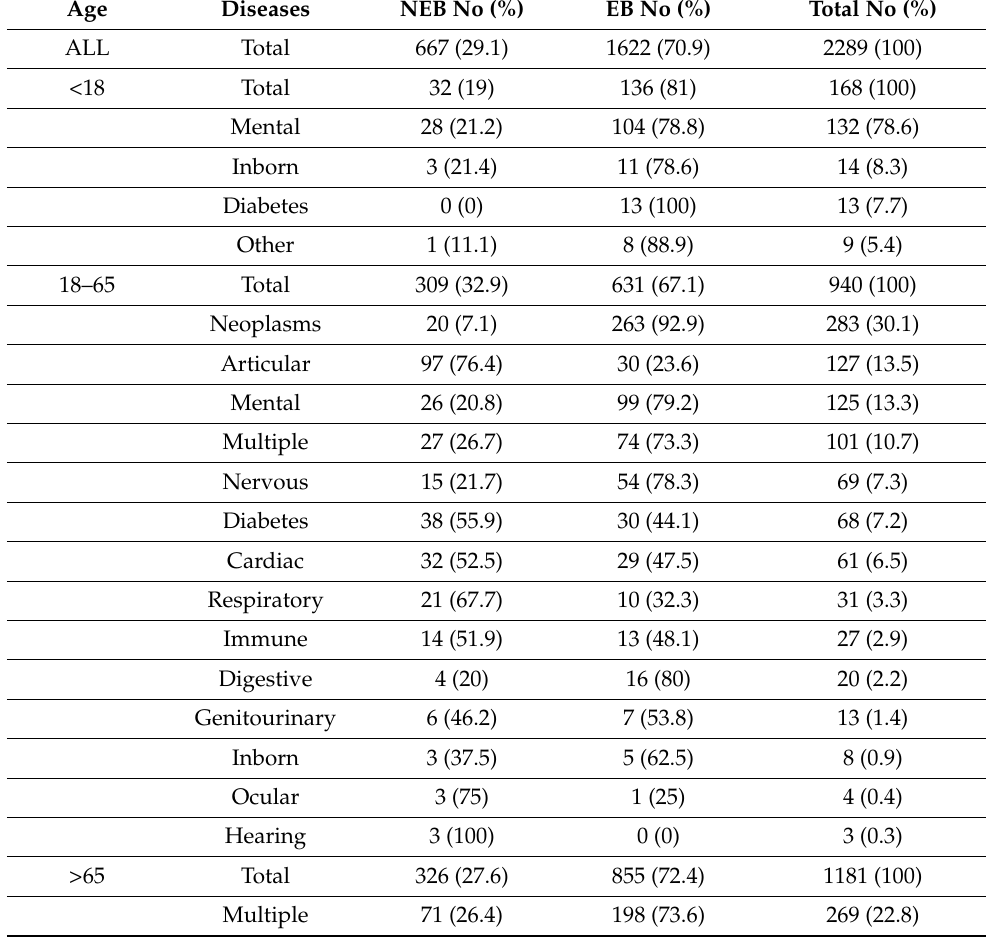
Table 8. Iglesias: economic benefits for civil invalidity or not in 2021